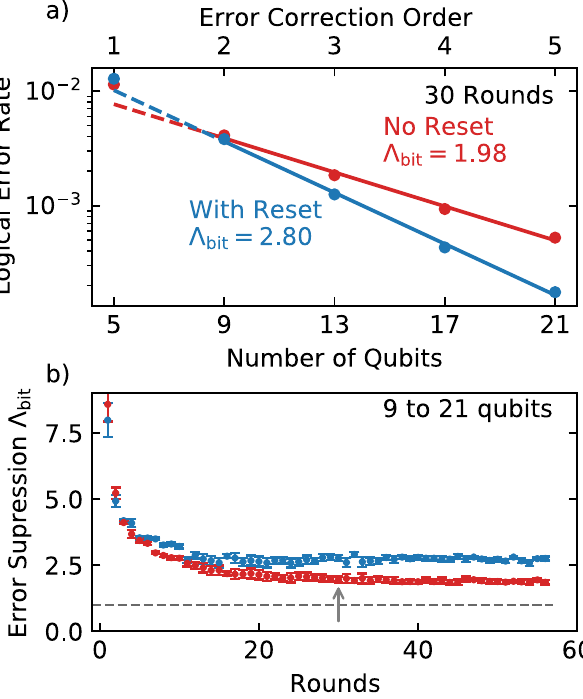
Fig. 6 Logical code performance. a The logical error rate for 30 rounds vs system size. The error suppression factor Λ bit is fi tted to the data from nine qubits up. b Λ bit versus code depth, showing that with reset logical error suppression is improved consistently. The error bars indicate the standard deviation error in the fi t of error rate versus number of qubits. The threshold for the bit- fl ip code (unity) is shown as a dashed line. The arrow indicates the data in ( a